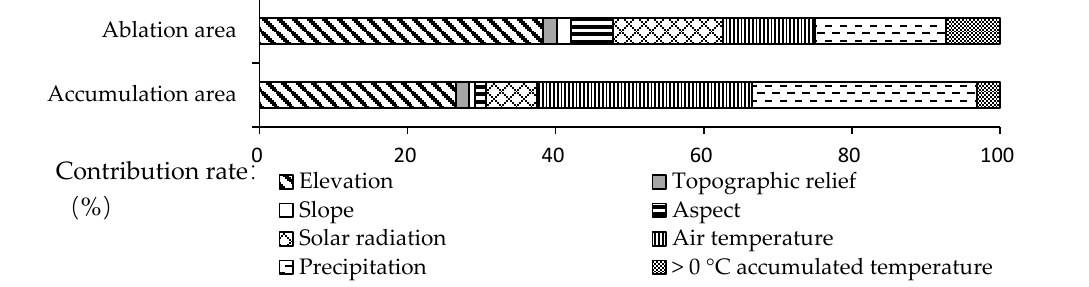
Figure 7. The contribution rate of each factor in the accumulation/ablation area. Table 3. Each factor’s statistical value in the accumulation/ablation area in the central Tianshan Mountains.